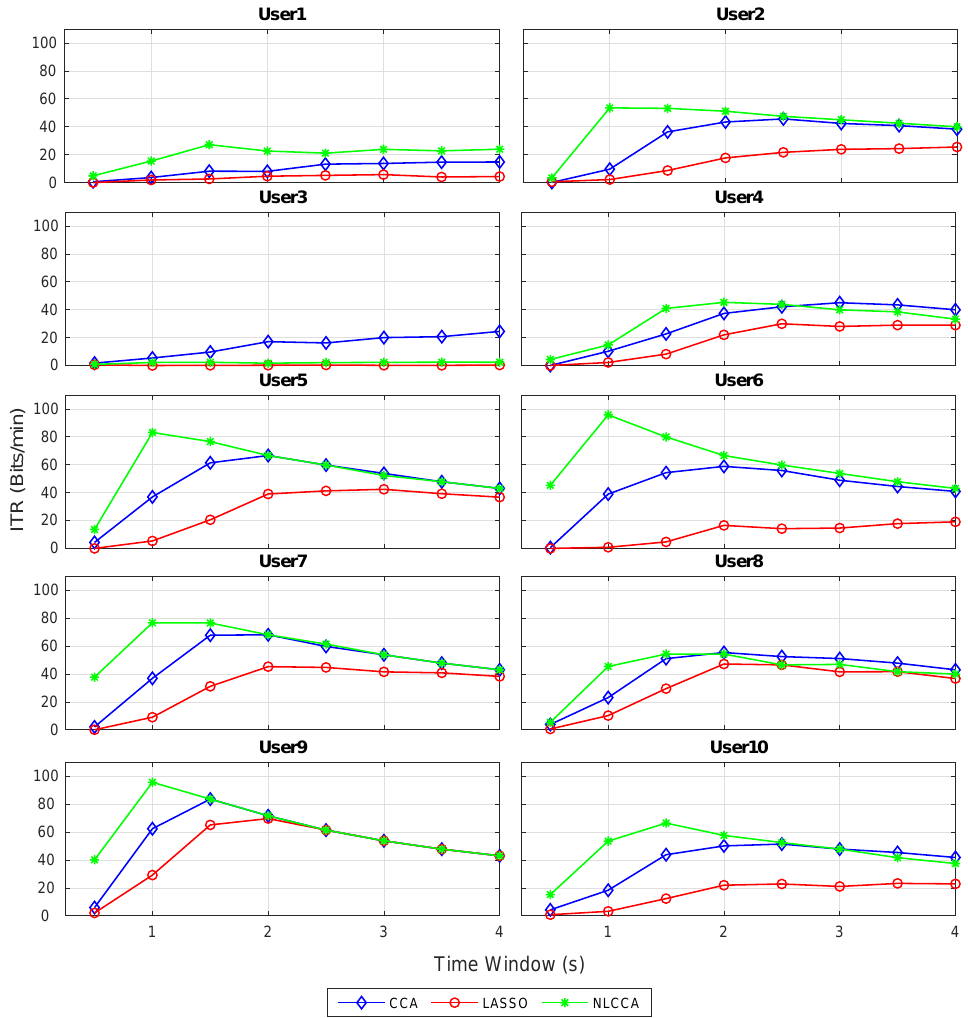
Figure 6. Comparison of ITR (information transfer rate) for each subject between CCA, LASSO, and